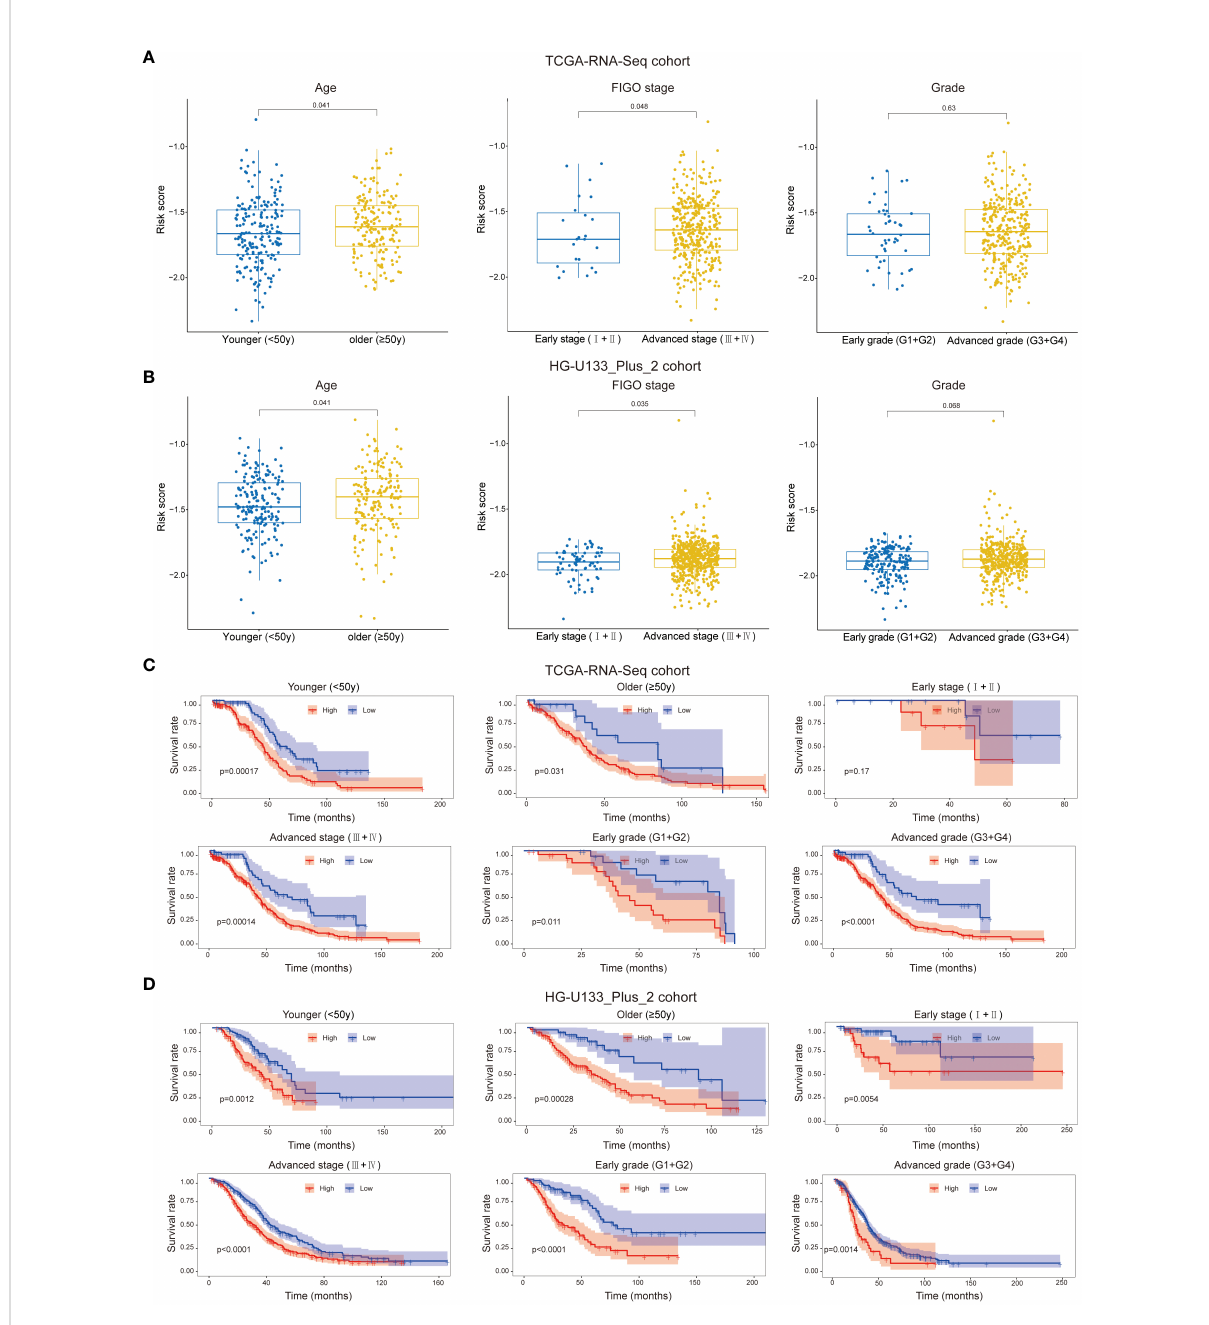
FIGURE 4 Patients with different clinicopathological features (including age, FIGO stage and Grade) had different levels of risk scores in TCGA-RNA-Seq cohort (A) and HG-U133_Plus_2 cohort (B) . Strati fi cation analysis suggested that the immune-related lncRNAs signature retained its prognostic value in multiple subgroups in TCGA-RNA-Seq cohort (C) and HG-U133_Plus_2 cohort (D) . The younger and older group were divided based on 50y; FIGO I+II were identi fi ed as early stage and FIGO III+IV were identi fi ed as advanced stage; G1+G2 were identi fi ed as early grade and G3+G4 were identi fi ed as advanced